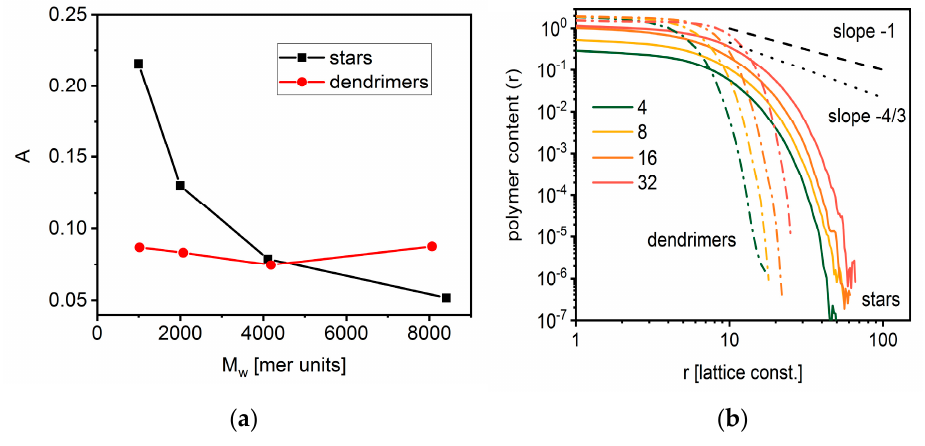
Figure 9. Asphericity as a function of polymer mass ( a ) and density profiles ( b ) for star-branched chains and dendrimers (see text for details).